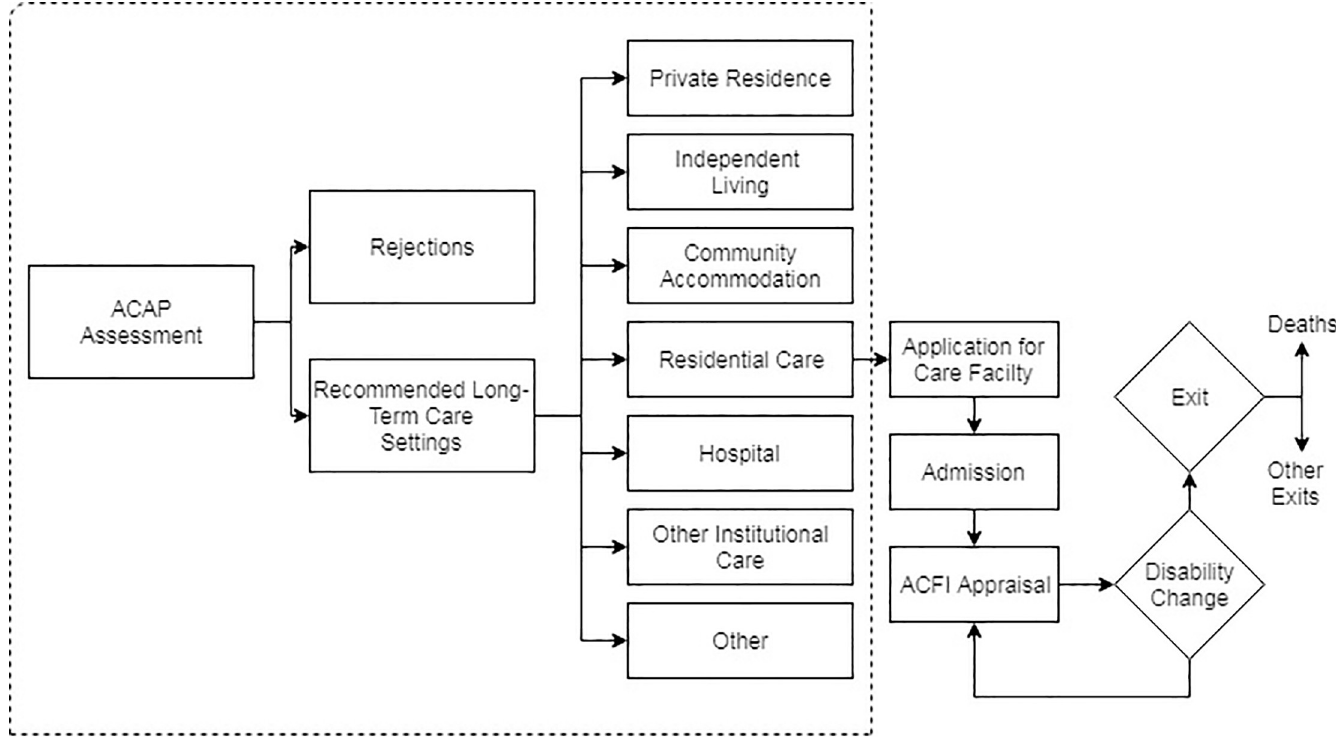
Fig 1. Individuals idealised pathway to care in Australia. Note: Our analysis pertains to the ACAP assessment in the highlighted box.